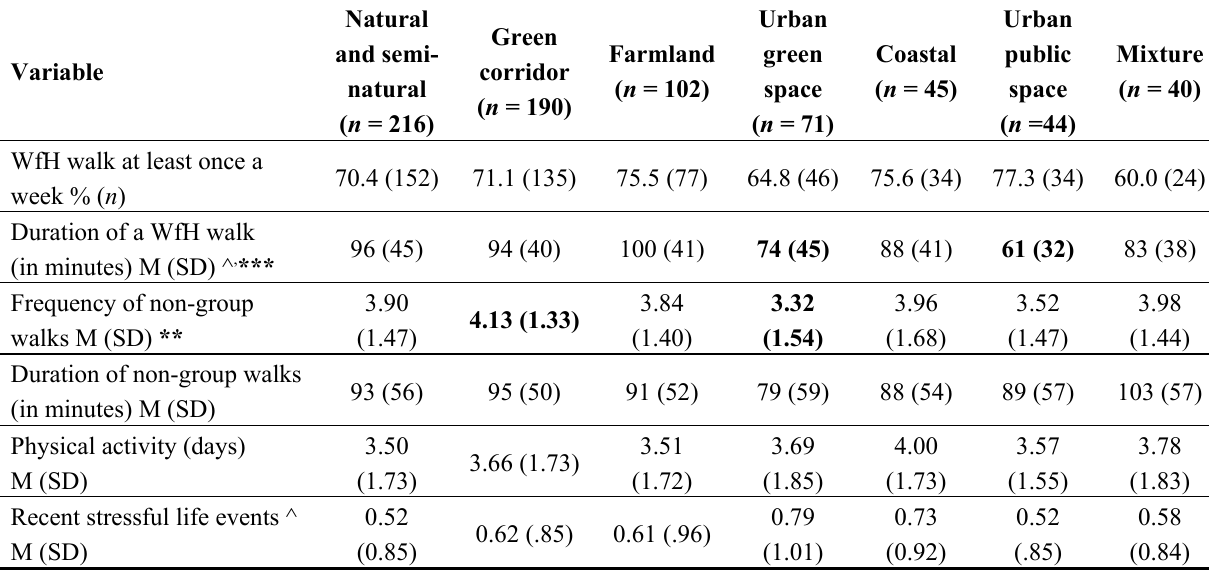
Table 3. Frequency and duration of WfH group and non-group walks, physical activity, and number of recent stressful life events of frequently attending WfH group walkers as a function of the main type of environment in which they walked with the group in the past 13 weeks ( n = 708).